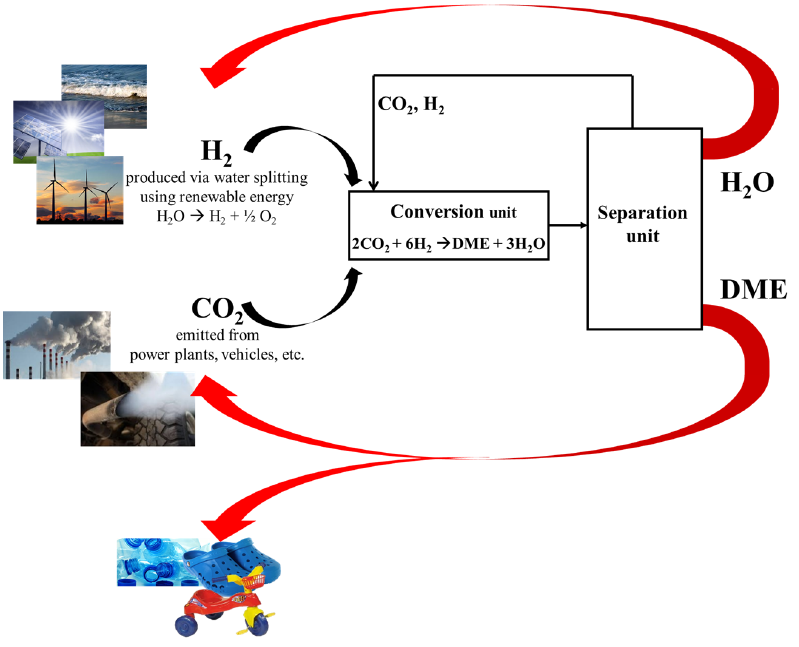
Figure 1. Proposed carbon cycle loop involving CO 2 as energy vector.